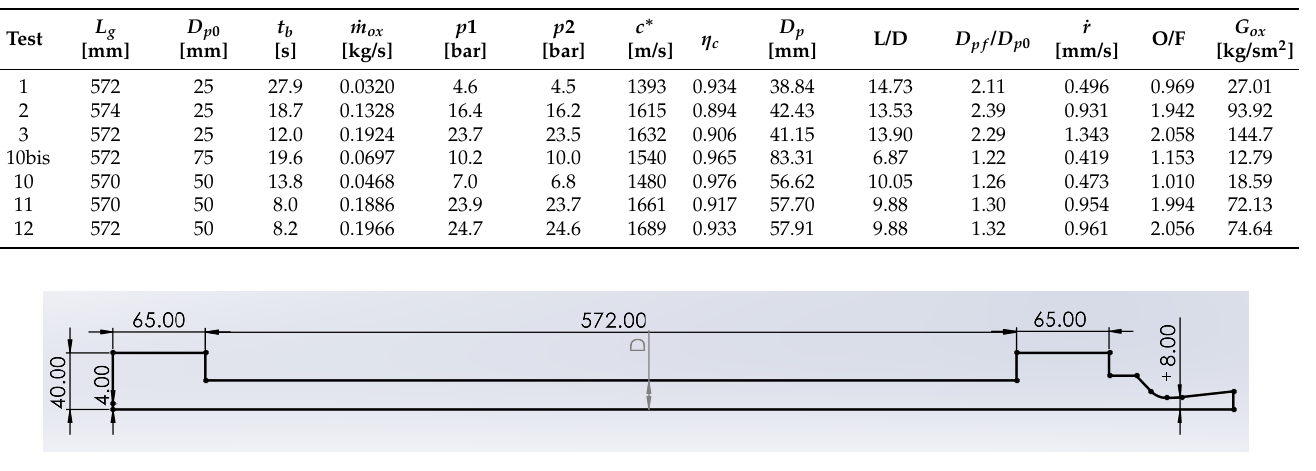
Figure 2. General dimensions of the reference hybrid rocket [34].